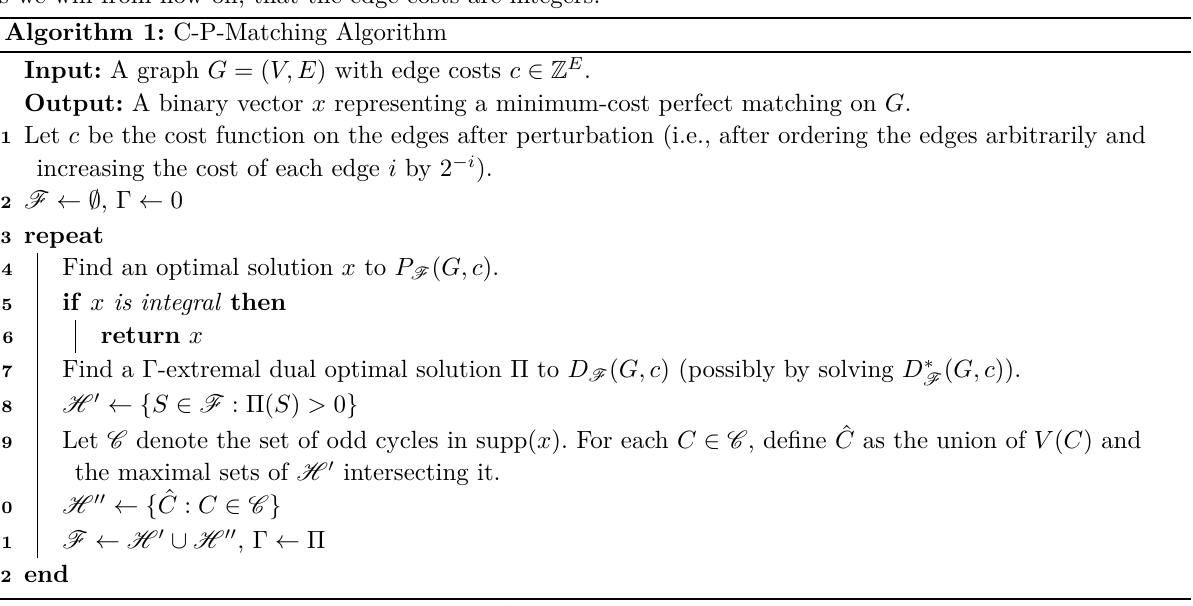
Algorithm 1: C-P-Matching